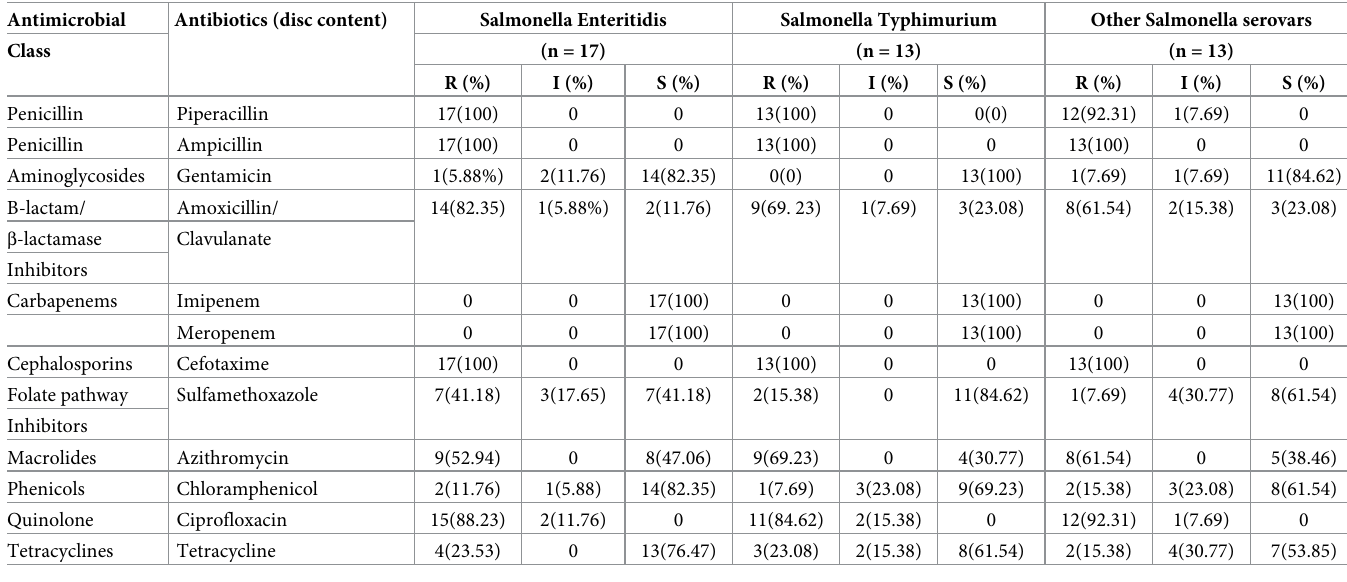
Table 2. Antimicrobial susceptibility profiles of the Salmonella serovars.